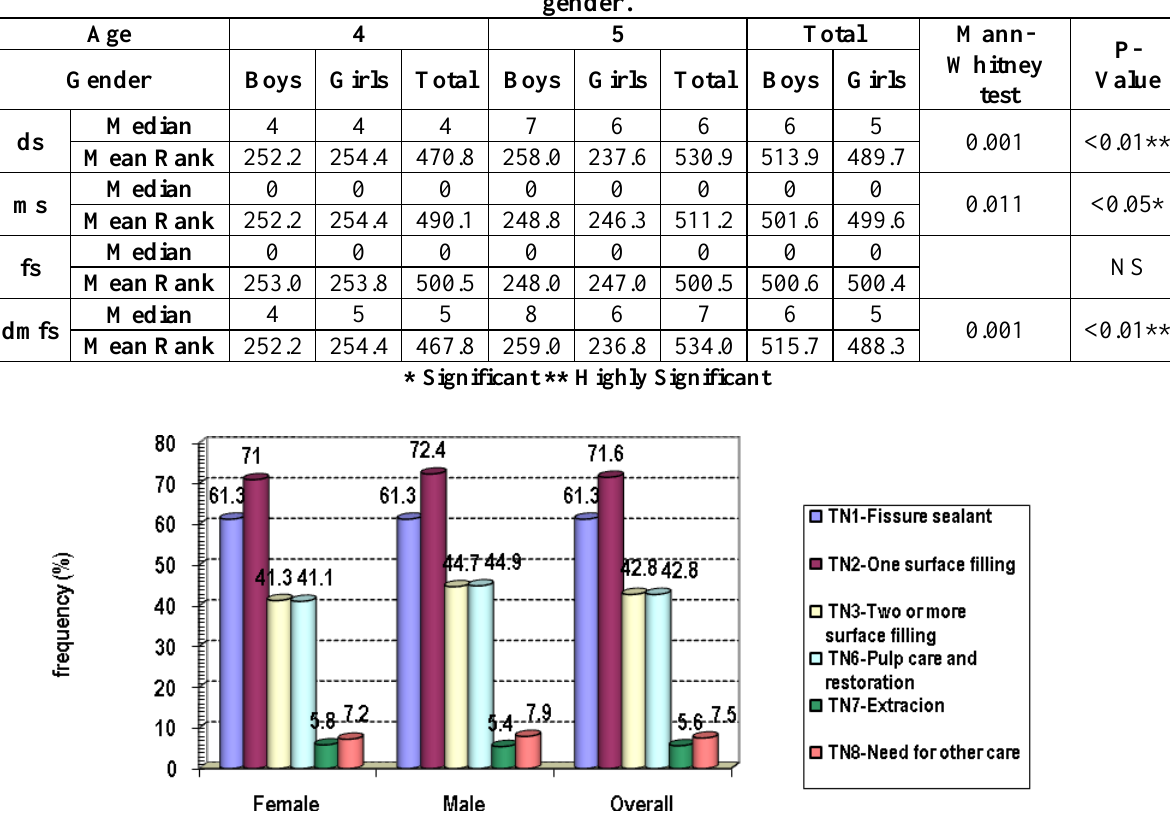
Figure 1: Distribution of children according to the type of the treatment need required by